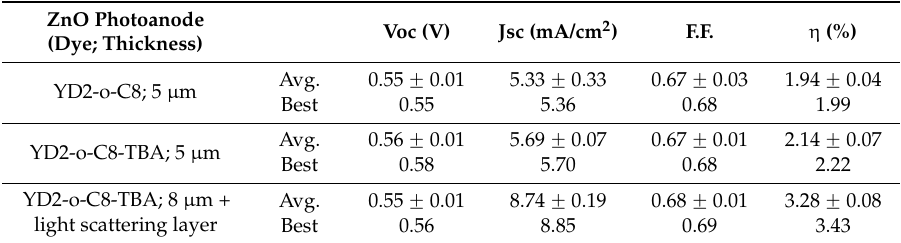
Table 2. Photovoltaic properties of YD2-o-C8-based ZnO DSSCs. ZnO Photoanode (Dye;